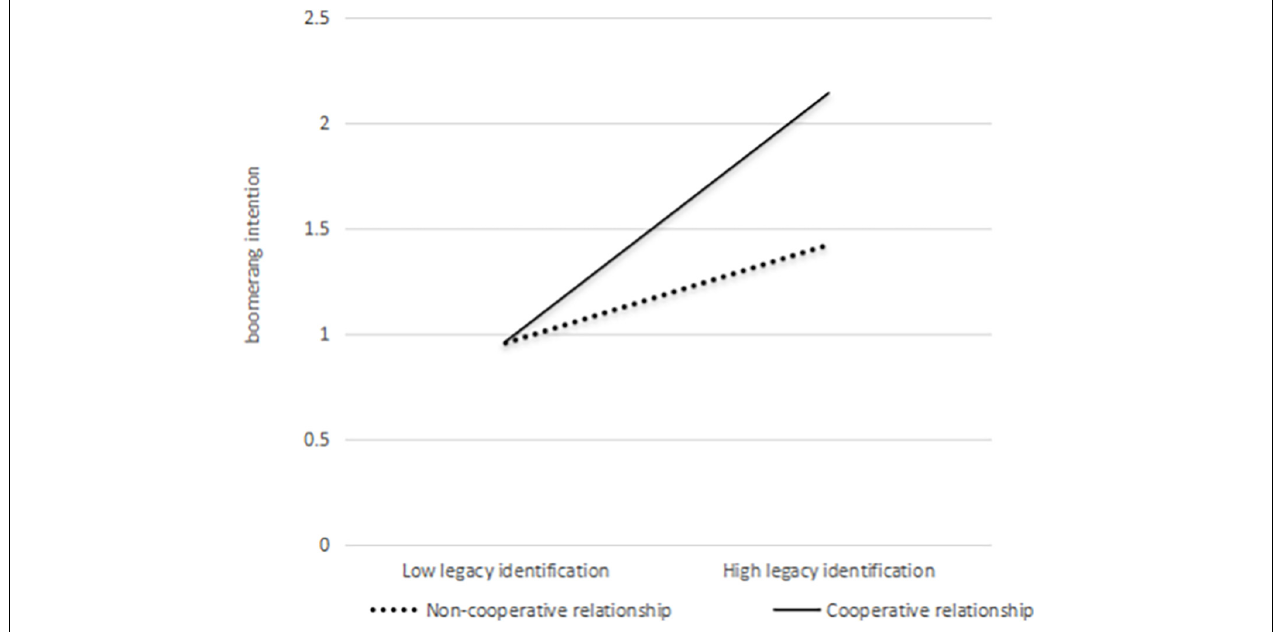
FIGURE 2 | Moderating effect of cooperative relationship on the relationship between legacy identification and boomerang intention.